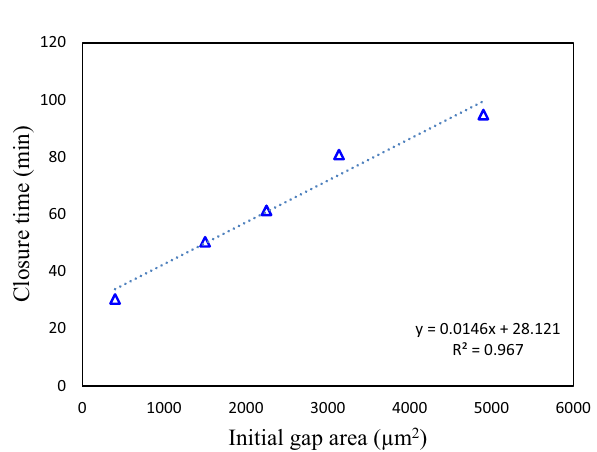
Figure 5. Wound area decreases with time, for different wound sizes ranging from 400 µ m